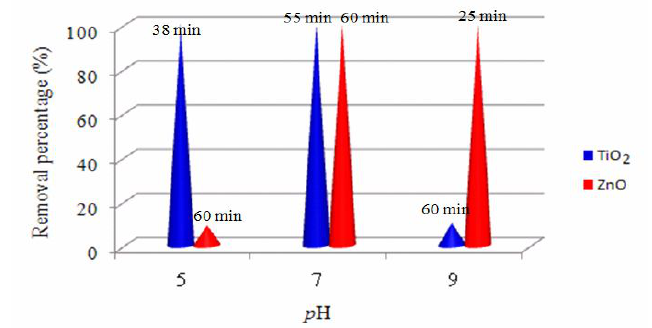
Fig. 7. Effects of pH on the degradation of MB in the presence of TiO